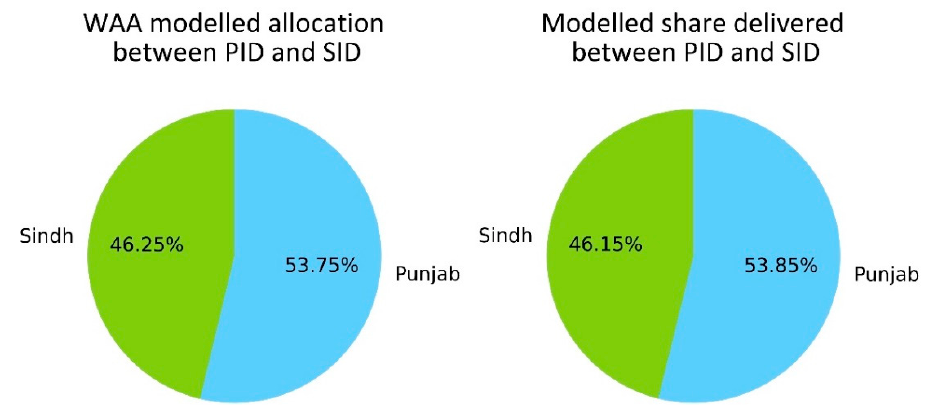
Figure 11. Modelled and observed water-sharing between Punjab Irrigation Department (PID) and Sindh Irrigation Department (SID) from 2002–2012.